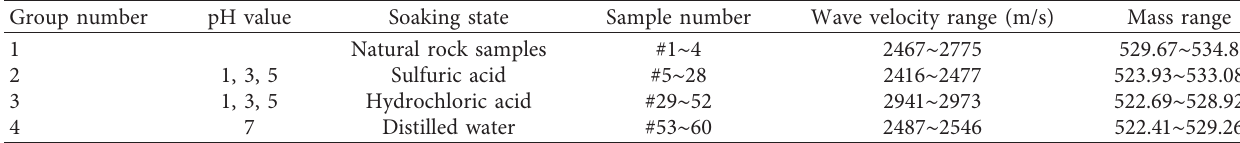
Table 2: Sandstone samples